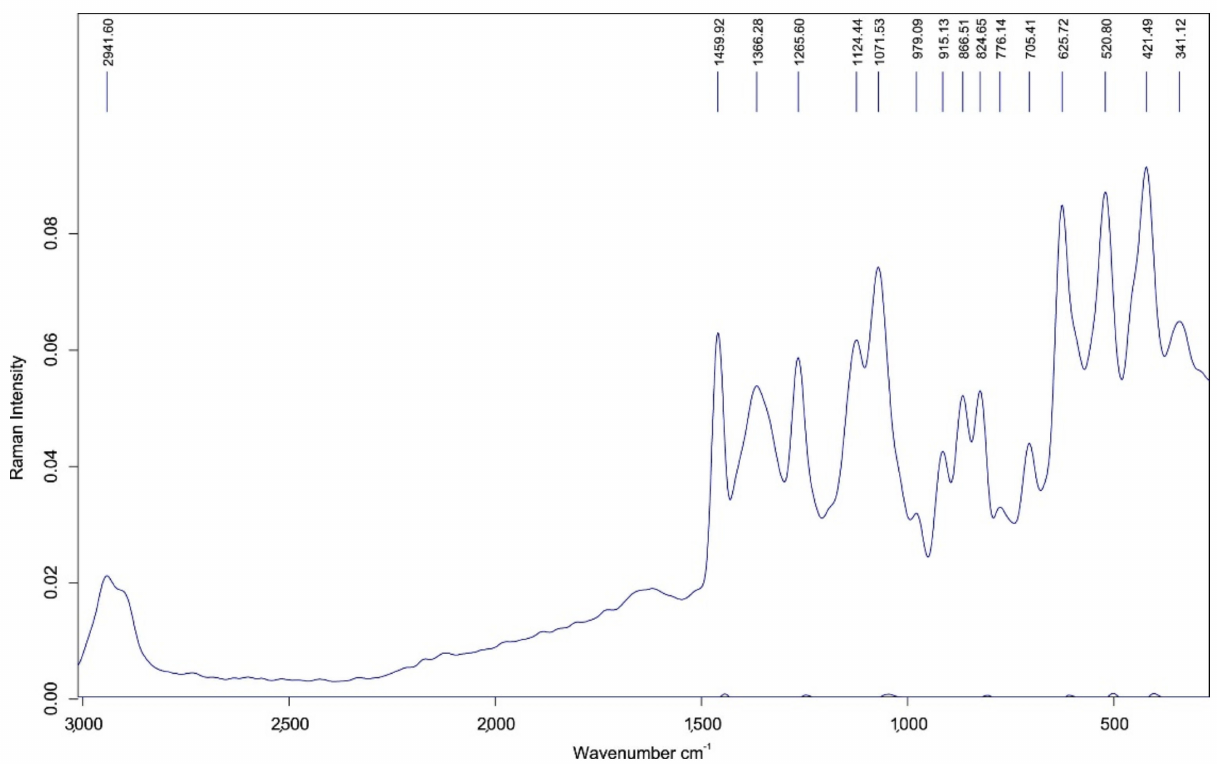
Figure 6. Average FT-Raman spectrum of the Lavandula spp. honey. Reprinted with permission from ref. [54]. Copyright 2017 Copyright Elsevier